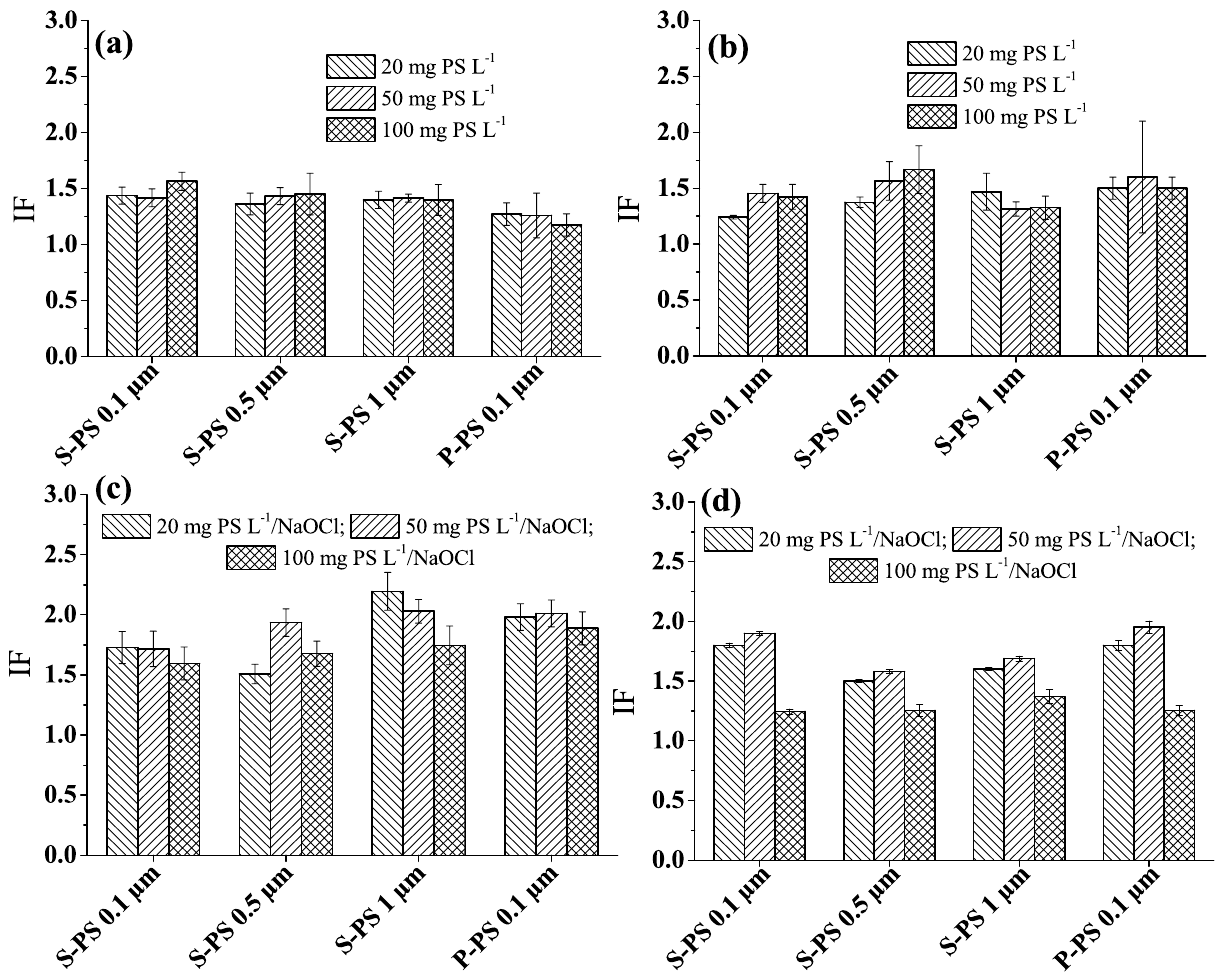
Figure 1. ( a ) Genotoxicity and ( b ) cytotoxicity of sulfate polystyrene (S-PS) particles of different sizes (0.1, 0.5 and 1 µm) and pristine, 0.1-µm polystyrene (P-PS) particles at particle concentrations of 20, 50 and 100 mg L −1 in Milli-Q water. ( c ) Genotoxicity and ( d ) cytotoxicity of S-PS and P-PS particles in Milli-Q water after chlorination (20 mg chlorine L −1 ). The error bars represent one standard